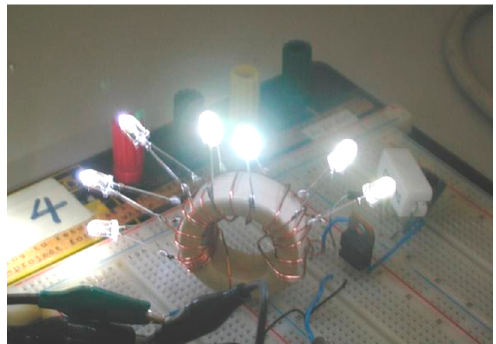
Figure A. The LED connected in inductor path. Figure A1. The LED connected in inductor